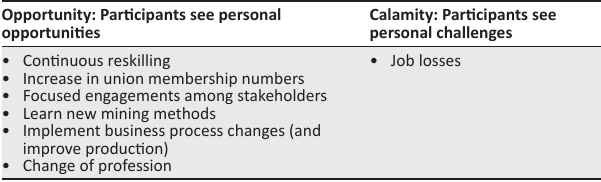
TABLE 2: Effects of mechanisation and modernisation at an individual